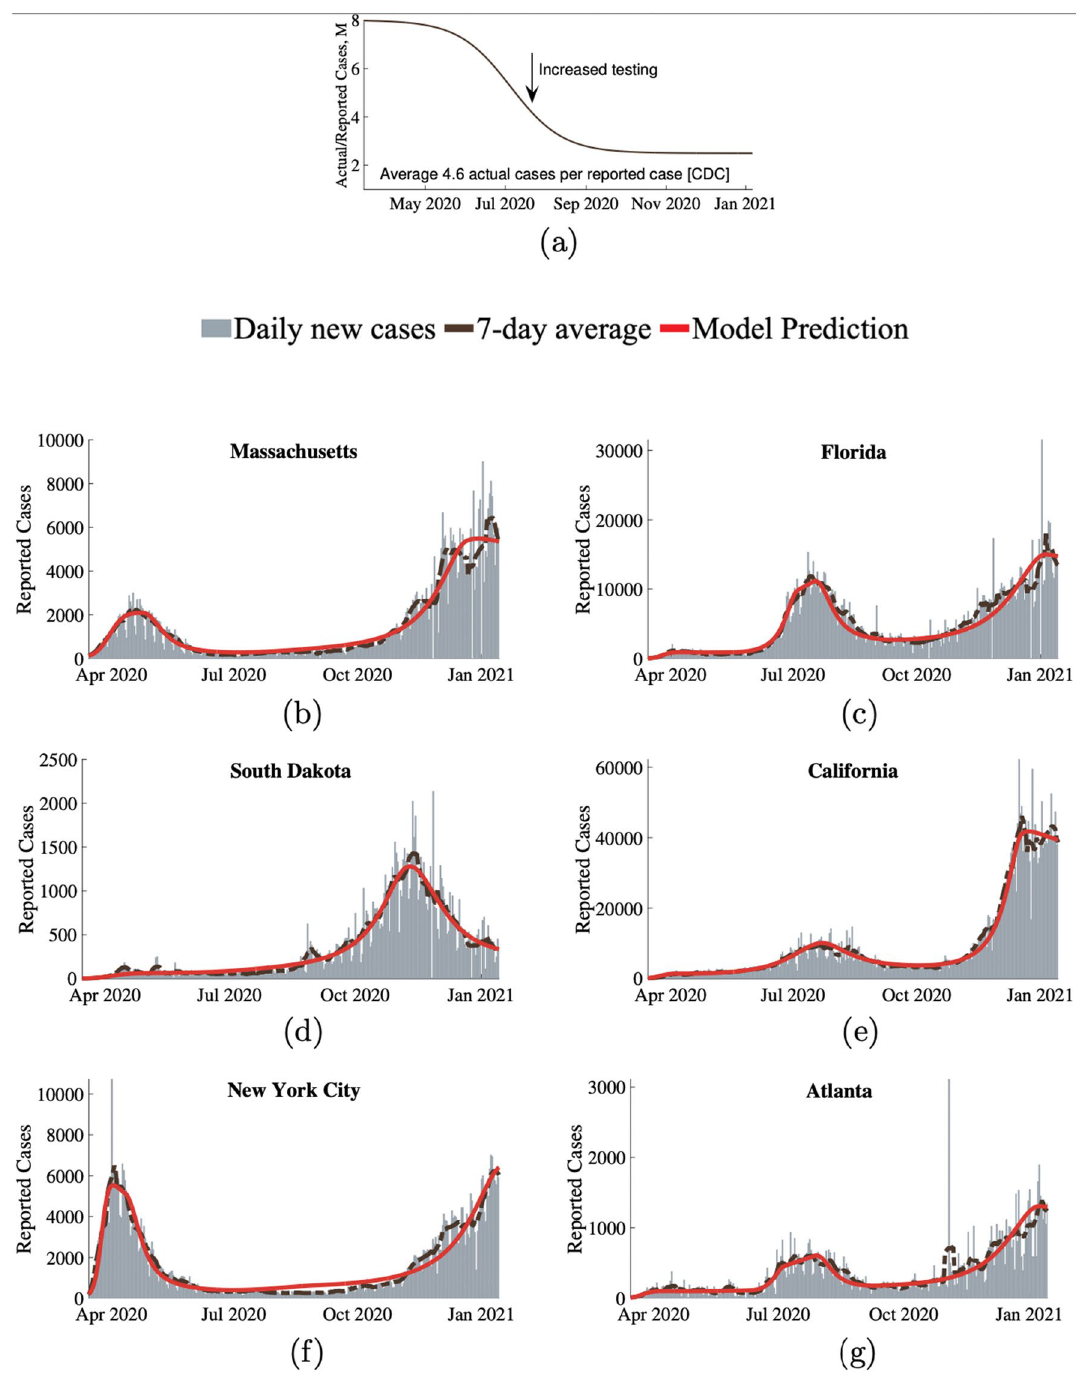
Figure 1. Results of our behavioral model’s fit to COVID-19 data across six populations in the United States. ( a ) Shows M representing the ratio of actual infectious cases to reported cases. Reported new infection case data versus model fit for ( b ) Massachusetts, ( c ) Florida, ( d ) South Dakota, ( e ) California, ( f ) New York City, and ( g ) Atlanta. Gray bars represent the daily reports of new COVID-19 cases. The dashed brown lines are the corresponding 7-day average. Our model’s predictions for reported daily cases are shown as the solid red